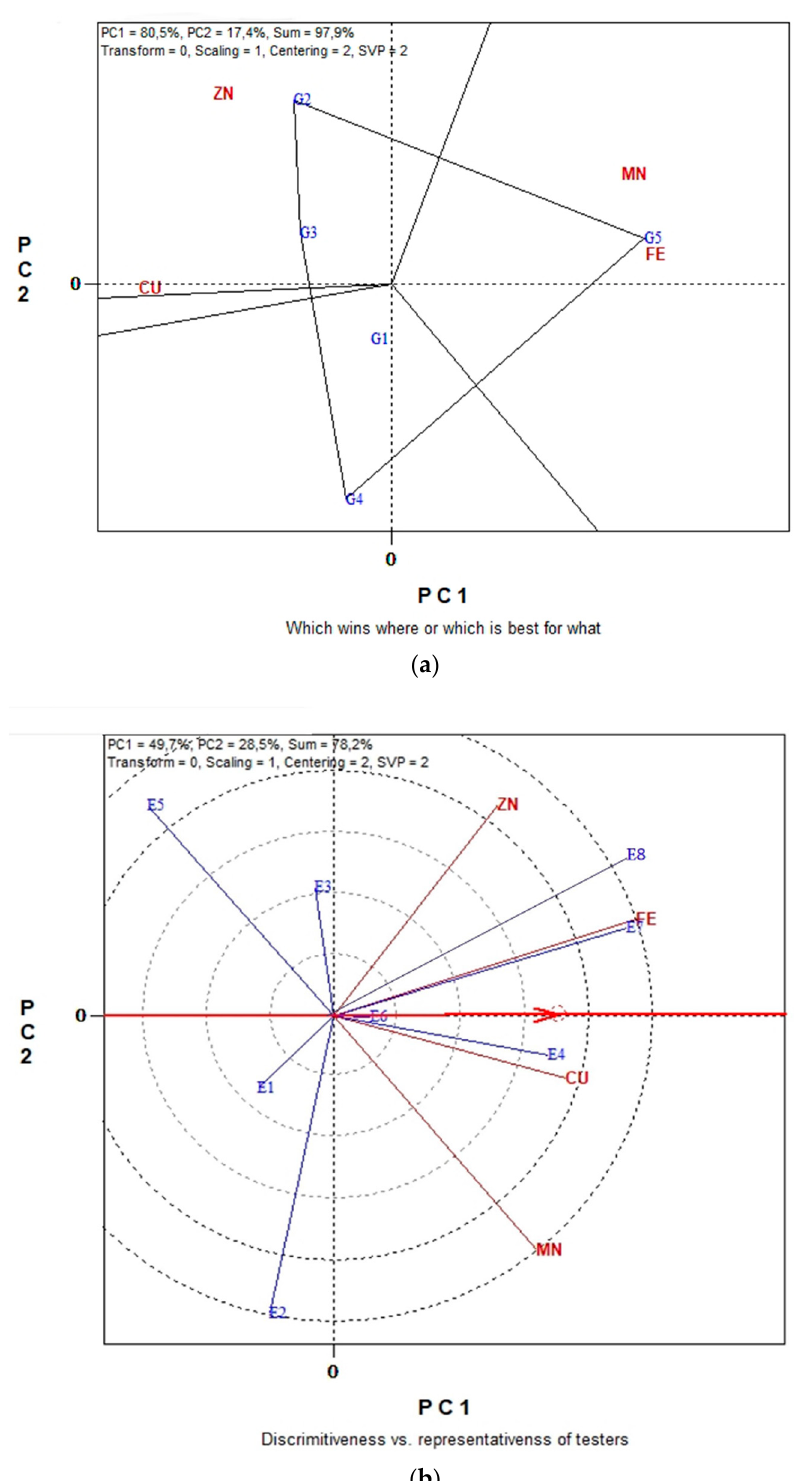
Figure 5. Biplot analysis of seed micronutrient content (Fe, Cu, Mn and Zn) in organic farming: ( a ) “which-won-where or which is best for what” view of the GGE biplot based on seed micronutrient contents (Fe, Cu, Mn and Zn) of five lentil genotypes in eight environments; ( b ) “Discriminating power vs. representativeness” view of the GGE biplot based on seed micronutrient contents (Fe, Cu, Mn and Zn) of five lentil genotypes in eight